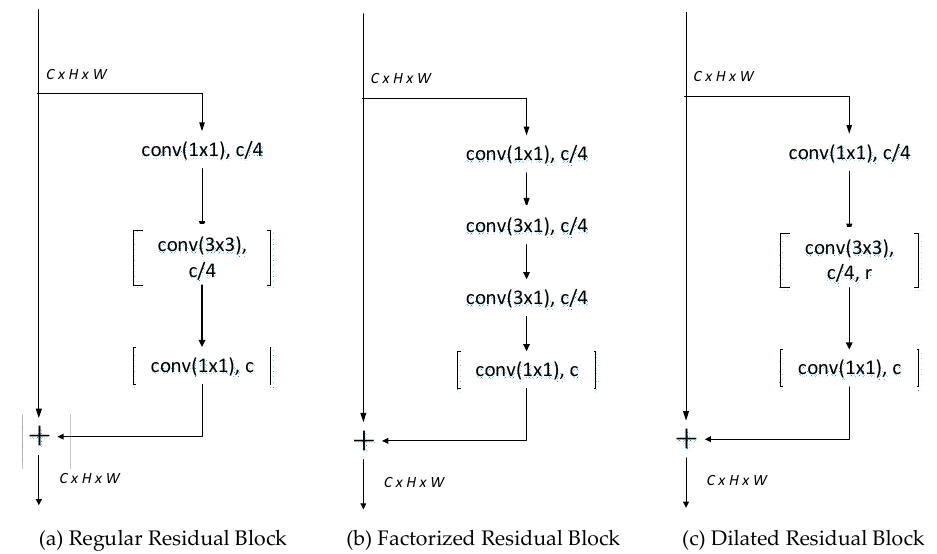
Figure 5. Residual blocks in our network.